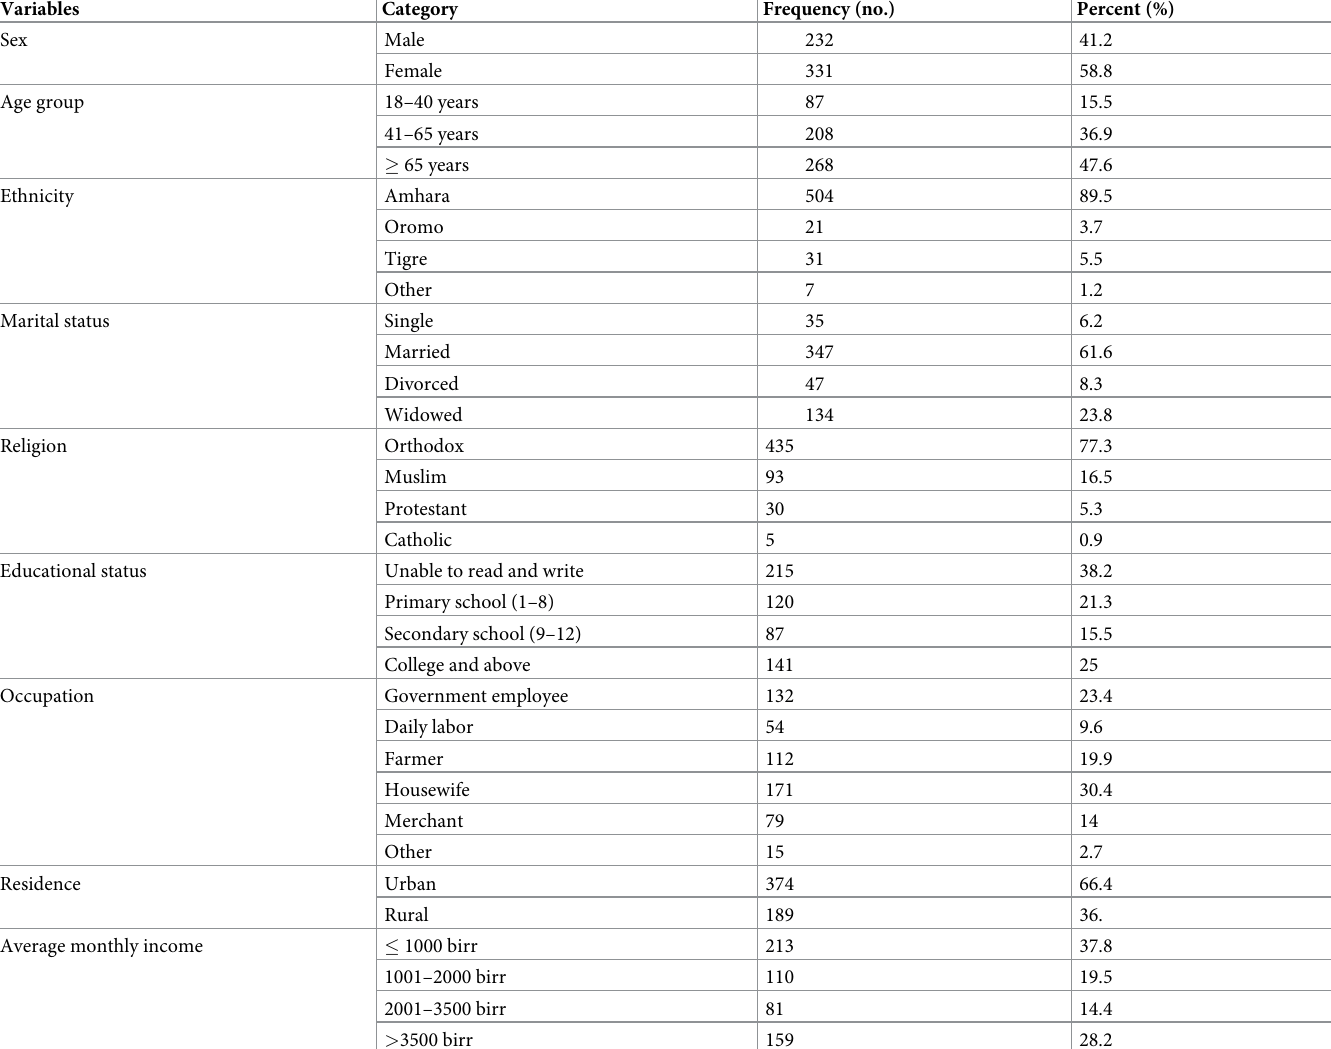
Table 1. Socio-demographic characteristics of adult HTN patients attending chronic follow-up care clinics in northwest Amhara regional state referral hospitals in Northwest Ethiopia in 2021 (n = 563).